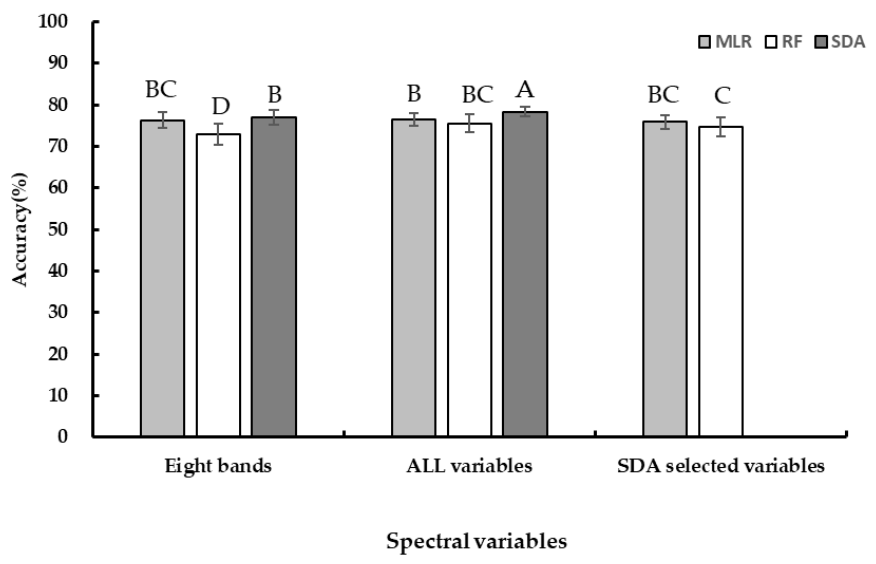
Figure 6. The overall accuracy for different classifiers and spectral variables. Error bars indicated the standard deviations of 10 classifications. Different letters (A, B, C, D) indicate significant difference ( p < 0.05).